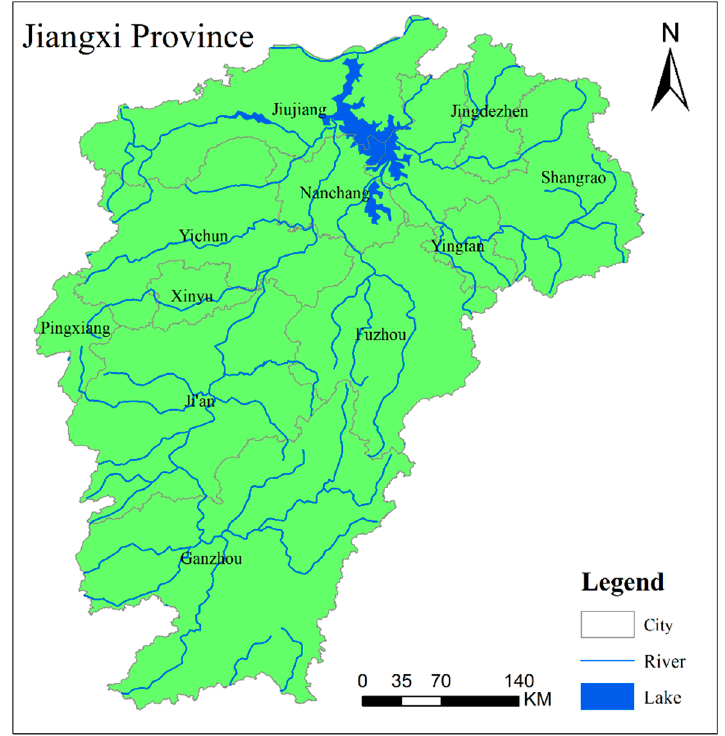
Figure 2. Geographical location of the study